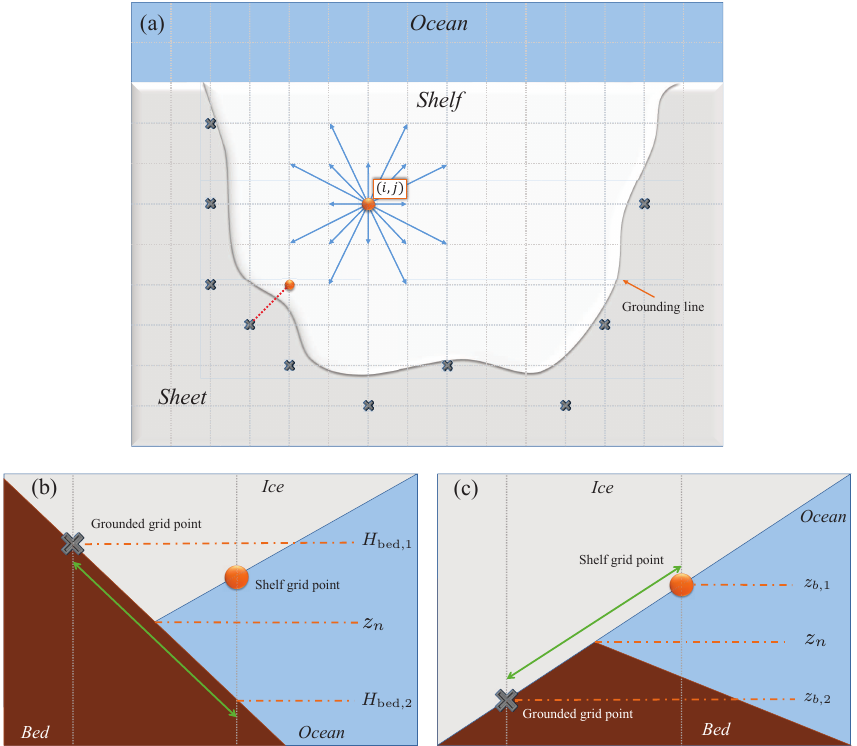
Figure 3. Schematic of the algorithm for finding the average grounding-line depth and associated slope angle used by the basal melt parametrization. (a) Top view of an ice shelf on a horizontal grid. The algorithm searches in 16 directions on the grid from the shelf point ( i , j ). Possible grounded points found in this way are marked by × . (b) Vertical slice along the n th direction (e.g. the red dotted line in a ). If the grounded point is higher than the previous shelf point, the grounding-line depth z n is found by interpolation along the bed (H bed , 1 + H bed , 2 )). (c) Interpolation along the ice base if the grounded point in the n th direction is deeper than the previous shelf ( z n = 1 2 (z b , 1 + z b , 2 ) point ( z n = 1 2